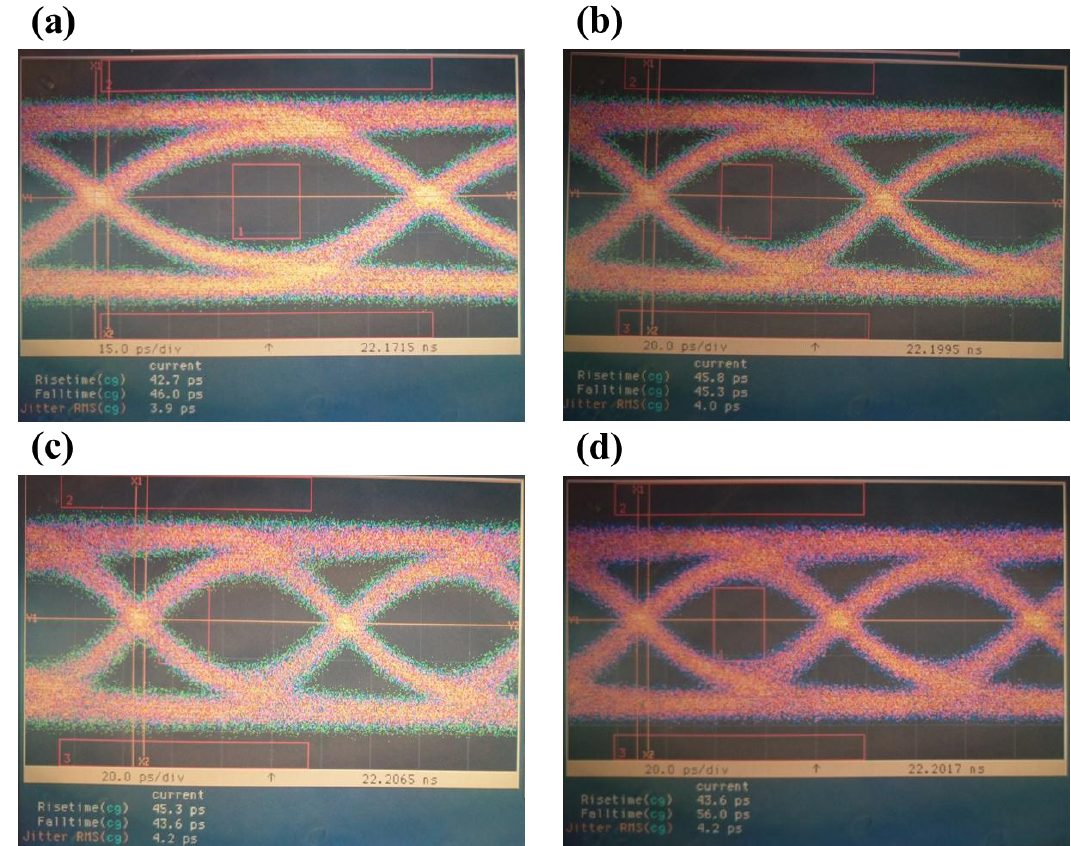
Figure 8. Eye diagrams obtained using the proposed SAGCM-APD photodetector chip operated under a multiplication gain of 5 using nonreturn-to-zero (NRZ) pseudorandom codes with length of 2 31 -1 at ( a ) 10, ( b ) 11, ( c ) 12, and ( d ) 12.5 Gb/s.